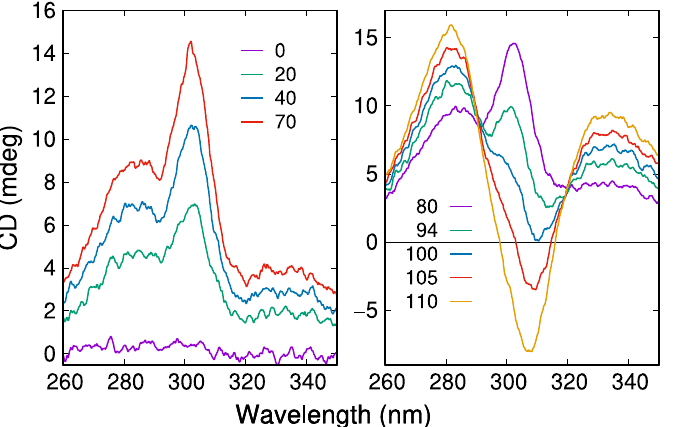
Figure 5. CD spectra of a Cu–NAC mixture at selected times (labels in minutes) from the start of the reaction. Initial concentrations: 40 mM HClO 4 , 300 μ M Cu 2+ , 300 μ M NAC; 12 °C.